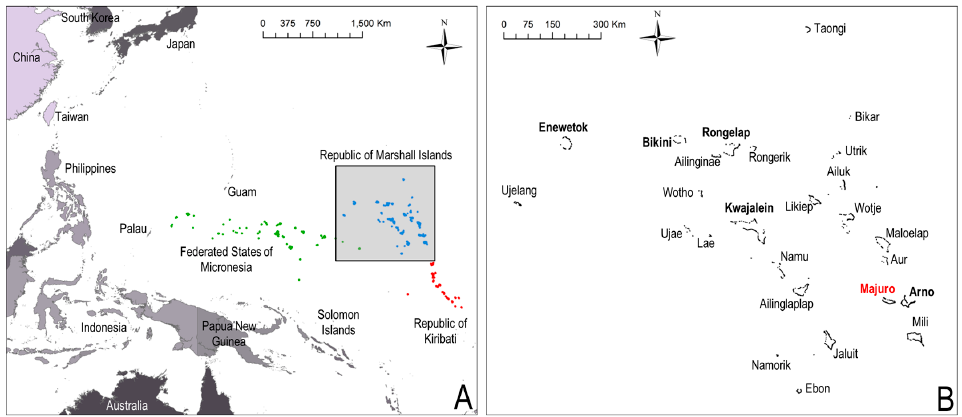
Figure 1. ( A ) Map of the western Pacific Ocean, showing the atoll nations of the Federated States of Micronesia (green), the Republic of Kiribati (red), and the Republic of Marshall Islands (blue); ( B ) a map of the Republic of Marshall Islands, with the capital island of Majuro shown in bolded red and all atolls on which groundwater studies have been conducted shown in bold.